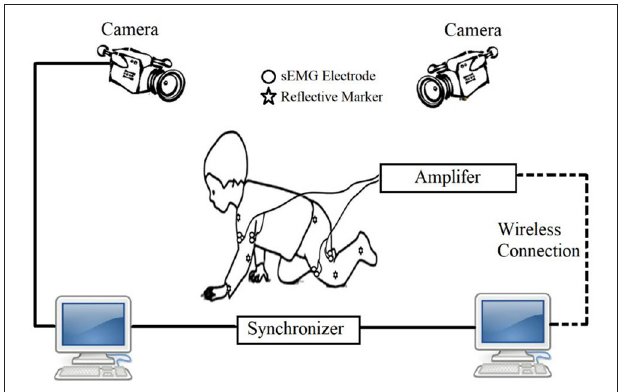
FIGURE 4 | Schematic of crawling measurement based on sEMG and motion capture